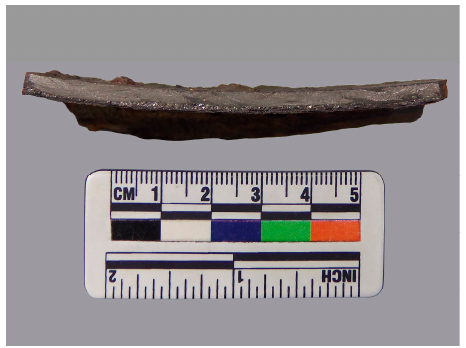
Figure 1. Cross-section appearance of the iron pot sample.